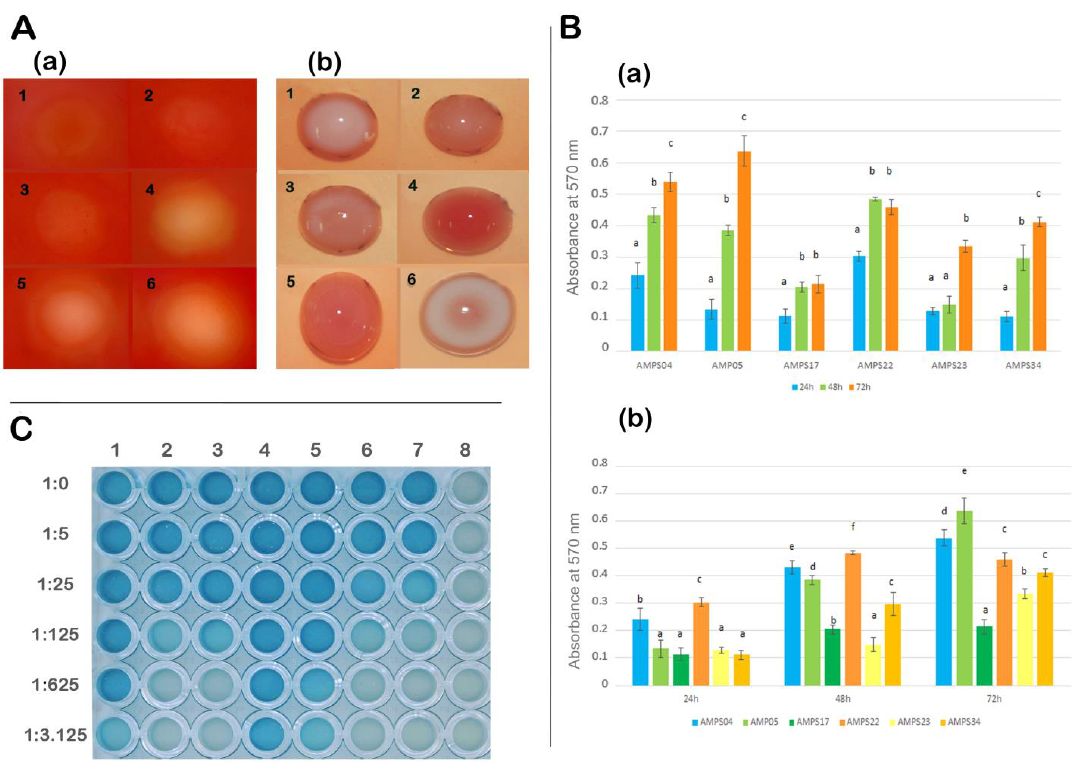
Figure 5. (Panel A ): Cellulase production on CMC (carboxy-methyl-cellulose) ( a ) and cellulose-like polysaccharides production on plates containing Congo Red ( b ) by the strains: 1. AMPS04, 2. AMPS05, 3. AMPS17, 4. AMPS22, 5. AMPS23, 6. AMPS34. (Panel B ): Absorbance values at 570 nm OD of CV-stained biofilms formed on PVC plates by the analyzed strains at di ff erent incubation times ( a ) and evolution along the time of these values for each strain ( b ). Each graph bar represents the average of at least eight wells. Error bars indicate the standard deviation. Values followed by the same letter in each treatment are not significantly di ff erent from each other at p = 0.05 according to Fisher’s Protected LSD test (least significant di ff erences). (Panel C ): Results of the bioassay production of quorum sensing molecules after serial dilutions of supernatants from liquid cultures of strains dispensed over a semisolid culture of the bioreporter strain Agrobacterium tumefaciens NTL4: 1. Positive control with 10 ng / mL of OHL (N-3-octanoyl homoserine lactone), 2. AMPS04, 3. AMPS05, 4. AMPS17, 5. AMPS20, 6. AMPS22, 7. AMPS34, and 8. Negative control with distilled